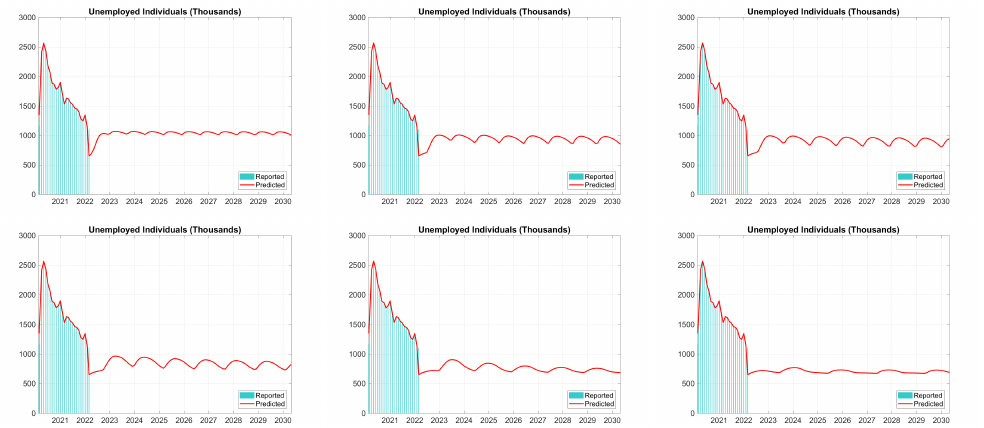
Figure 8. Predictions of the daily number of unemployed individuals in Canada considering periodic vaccination booster campaigns with periods of 270, 360, 390, 450, 540, and 720